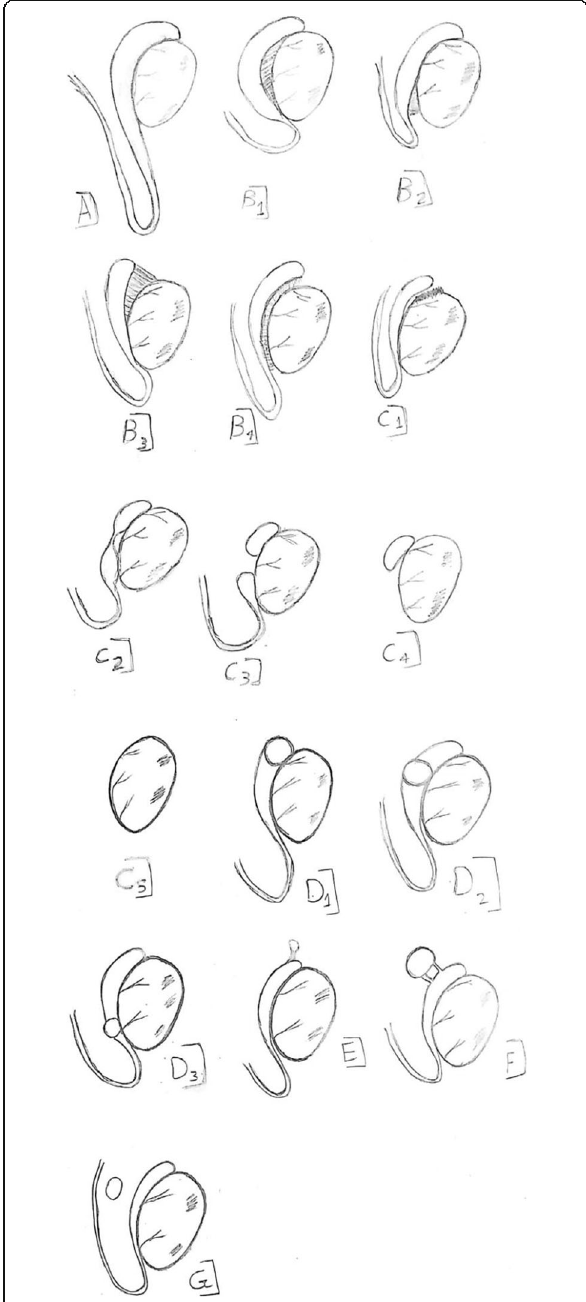
Fig. 1 Congenital anomalies of the epididymis [5]. A Elongated (looping) epididymis. B Anomalies of attachment to the testis [6]. B1 Attachment of caput and cauda (detached corpus). B2 Attachment of caput only. B3 Attachment of cauda only. B4 Complete separation of the testis and epididymis. C Epididymal anomalies of obliteration (agenesis) [1]. C1 Obliteration of the efferent ducts. C2 Obliteration of the epididymal body. C3 Epididymal body separated into two parts. C4 Agenesis of the distal half of the epididymis.